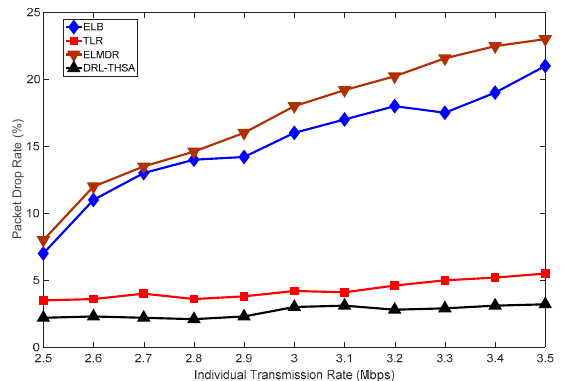
Figure 6. The packet drop rate with different number of rates.